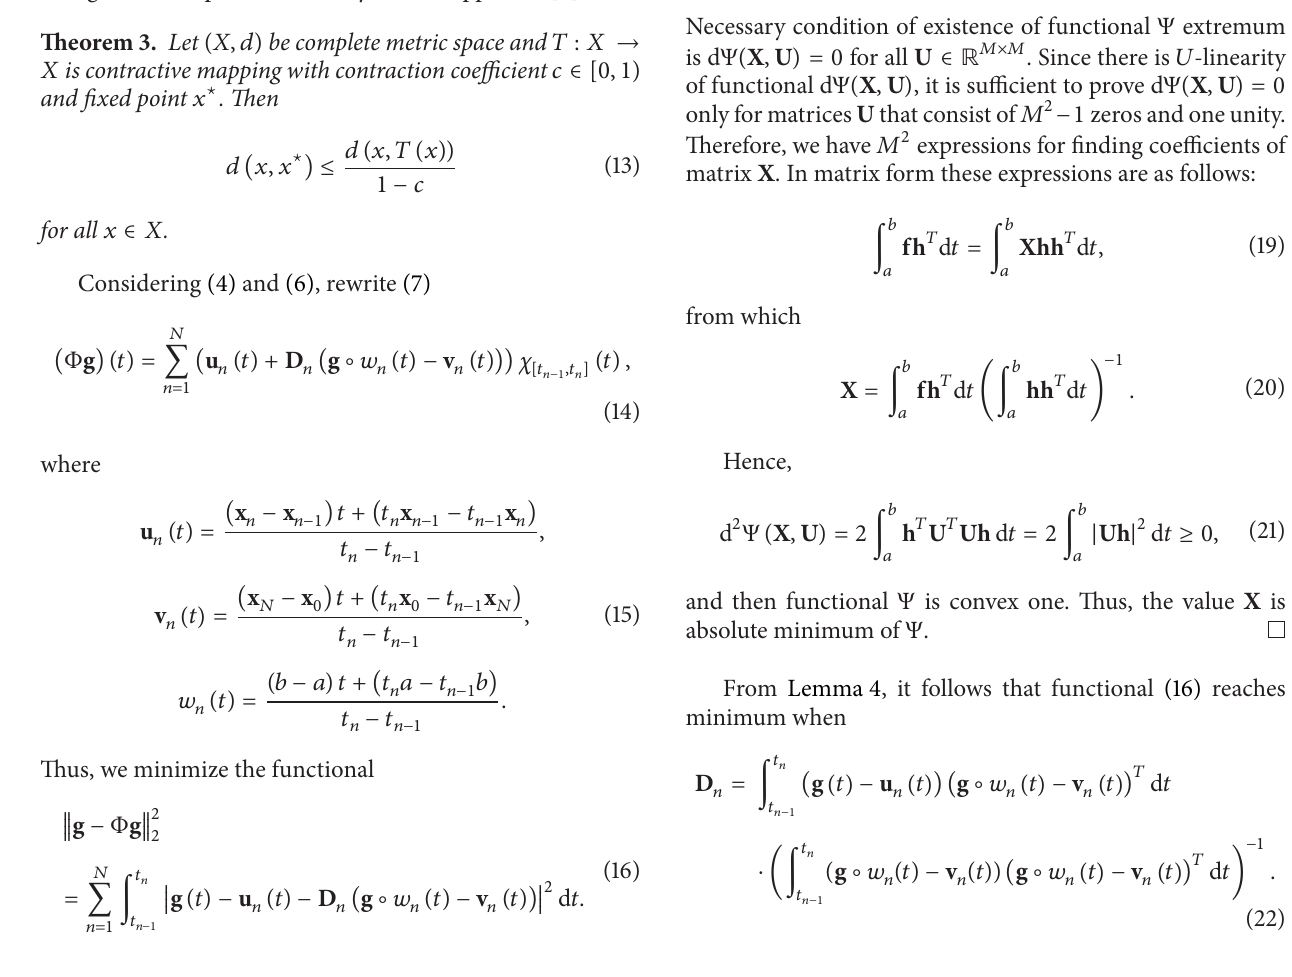
𝑀 [𝑎, 𝑏] → 𝐿 𝑀 [𝑎, 𝑏] is a contractive operator and Thus, Φ : 𝐿 2 2 g ⋆ is its fixed